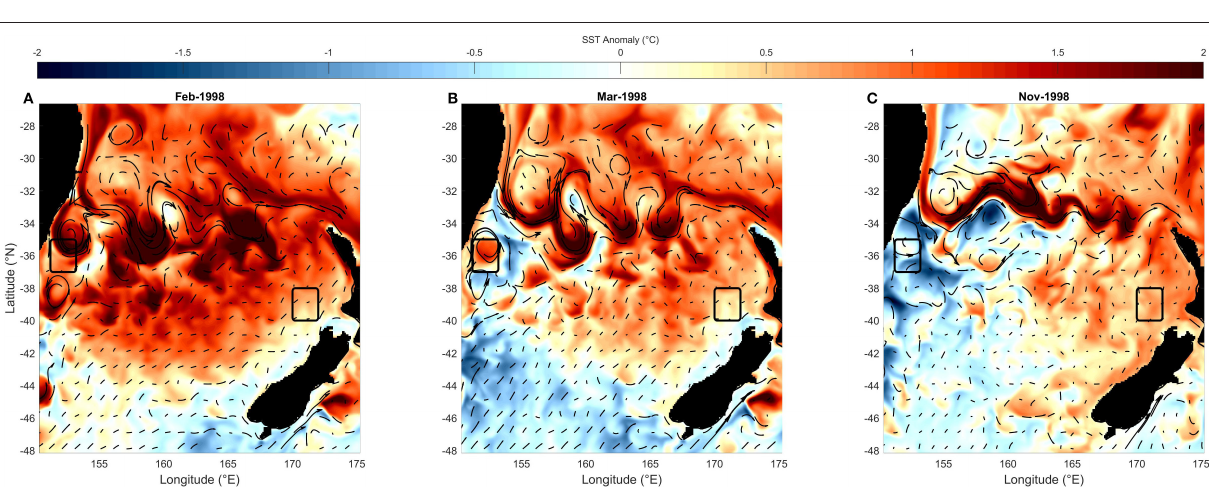
FIGURE 7 | Surface plots of monthly mean surface temperature anomaly (in the NZ box) in 1998: (A) February, (B) March, and (C) November. Surface temperature anomaly is shown with the colourbar and currents are shown with arrow